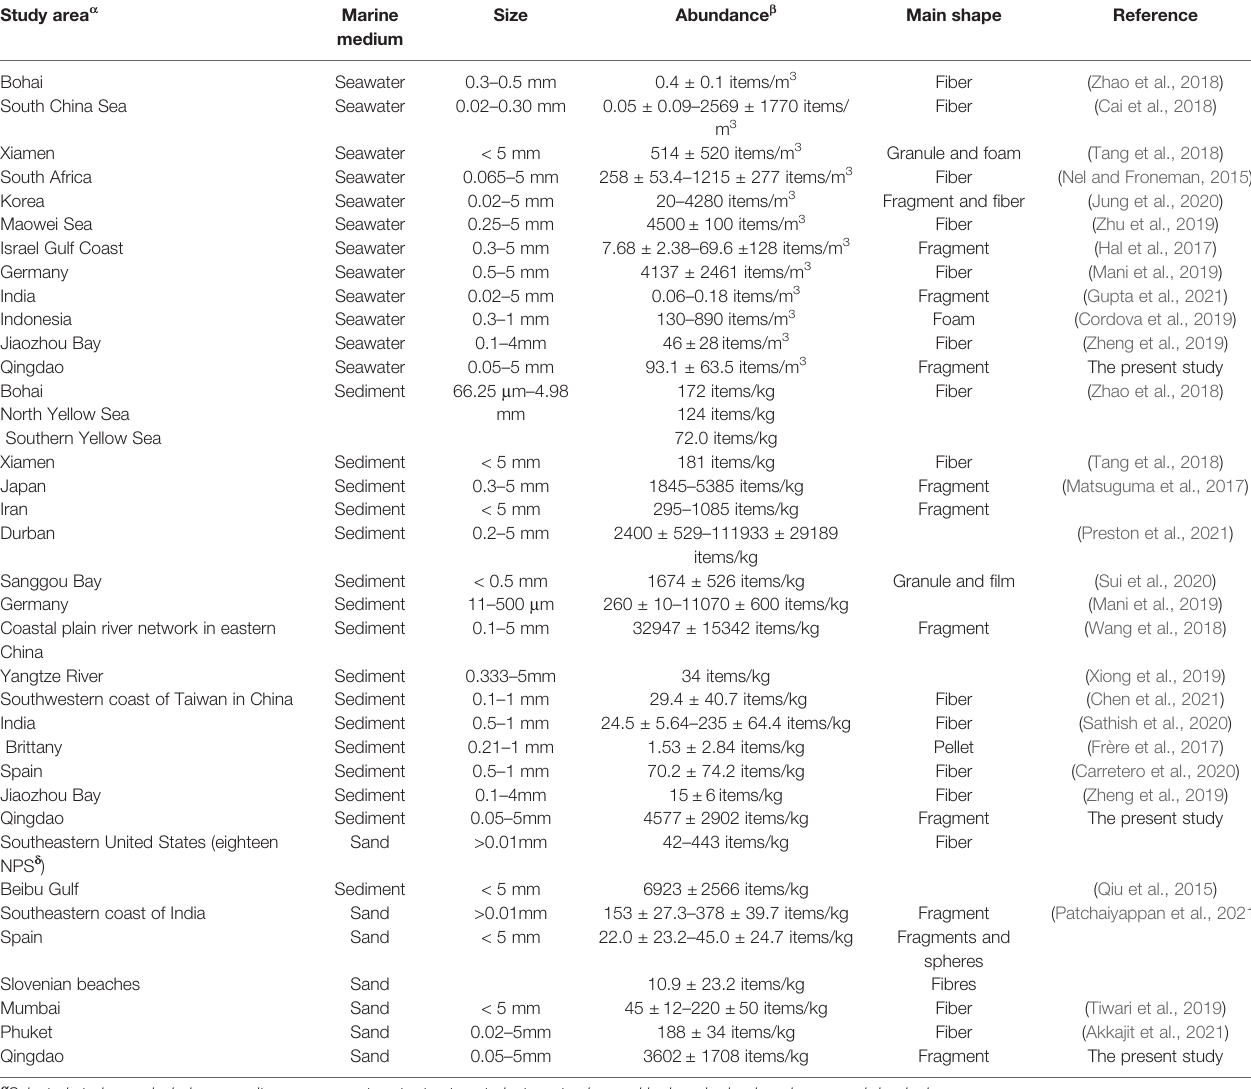
TABLE 1 | Summary of MP pollution in seawater, sediment, and sand in coastal regions around the world. Study area